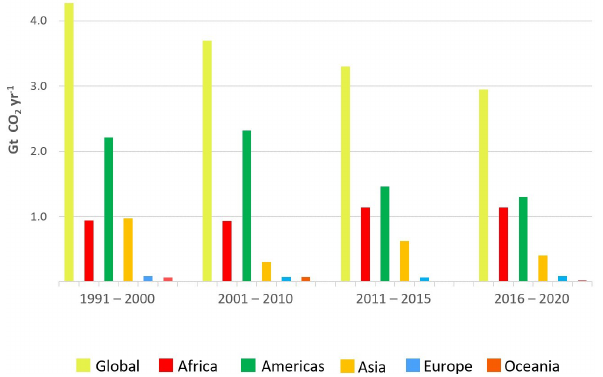
Figure 2. Estimates of emissions from net forest conversion (NFC) based on FRA 2020 for global (acid green) and regional (Africa: red; Americas: green; Asia: gold; Europe: sapphire; Oceania: or- ange) totals in GtCO 2 yr − 1